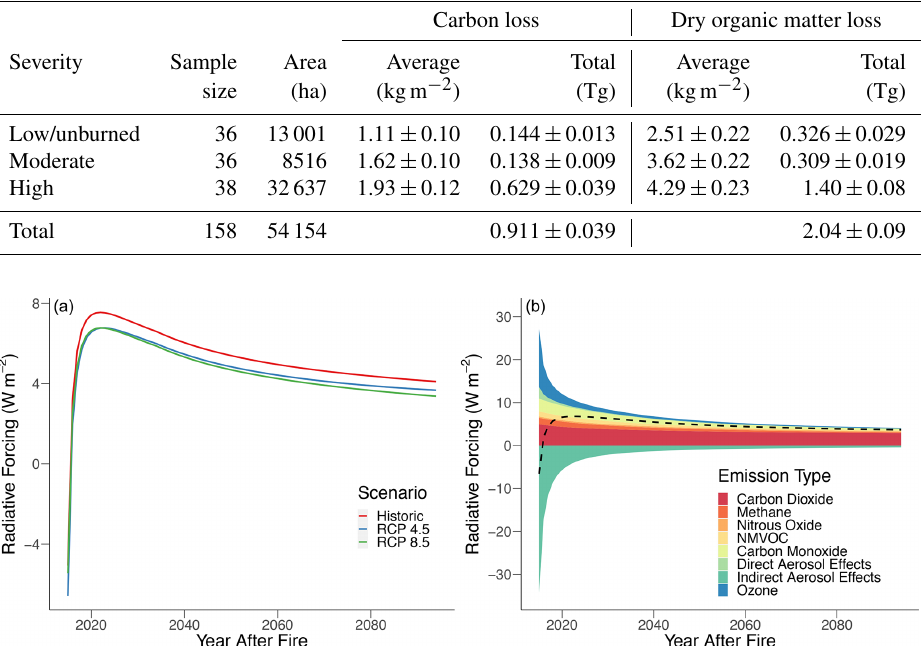
Table 2. Carbon and organic matter loss averaged within each burn severity category across reference point, as well as total carbon and organic mass loss over each burn severity category area. Total loss per burn severity category is summed to calculate total loss over the total fire area by burn severity classification. Error is reported as SEM, except for total loss over the fire area which is reported as the sum of errors.